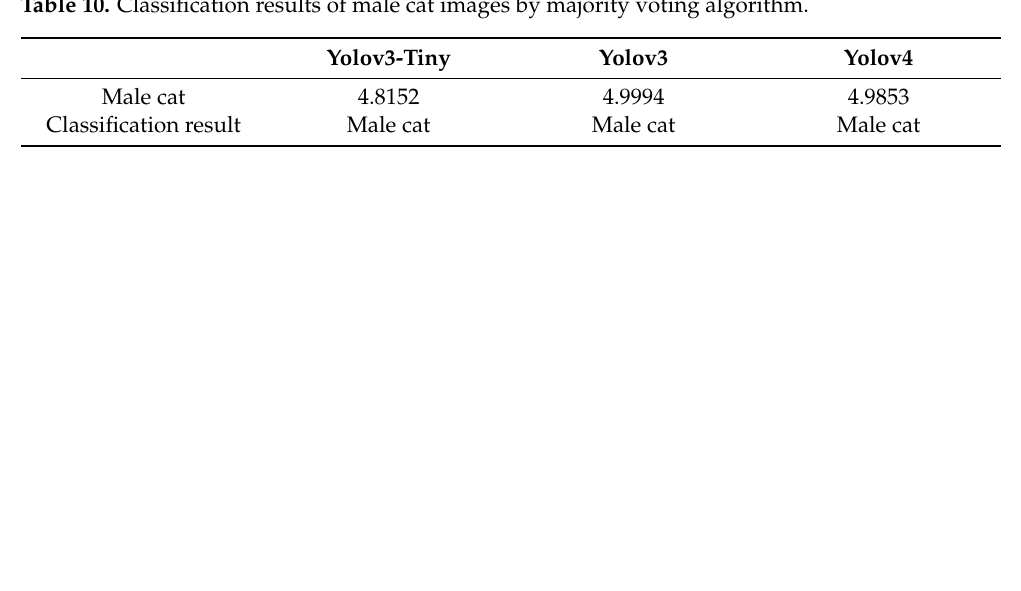
Table 10. Classification results of male cat images by majority voting